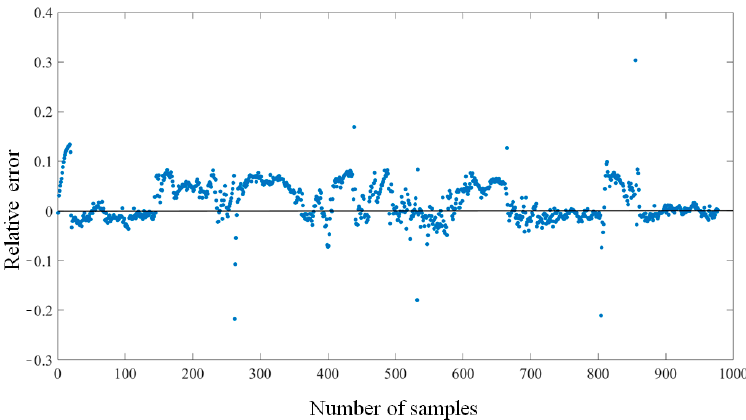
Figure 8. Relative error of model training.